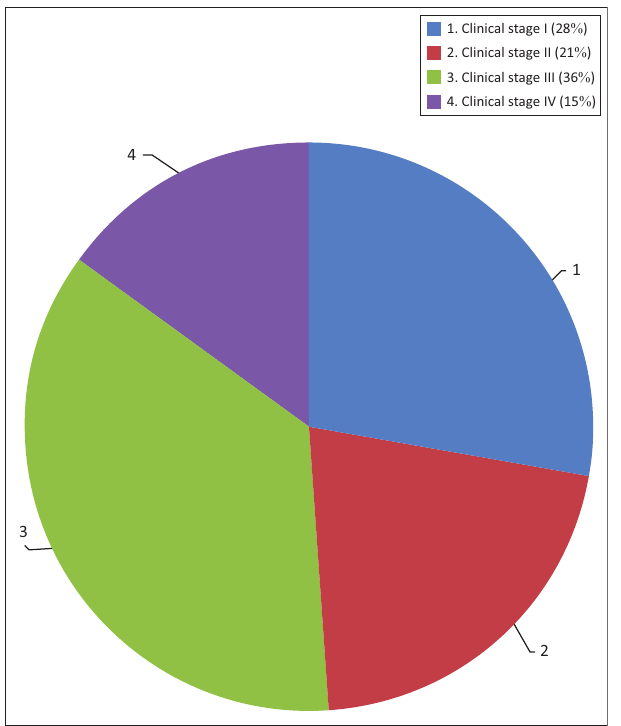
FIGURE 1: Clinical stage at initiation of combination antiretroviral therapy. ( n = 206)